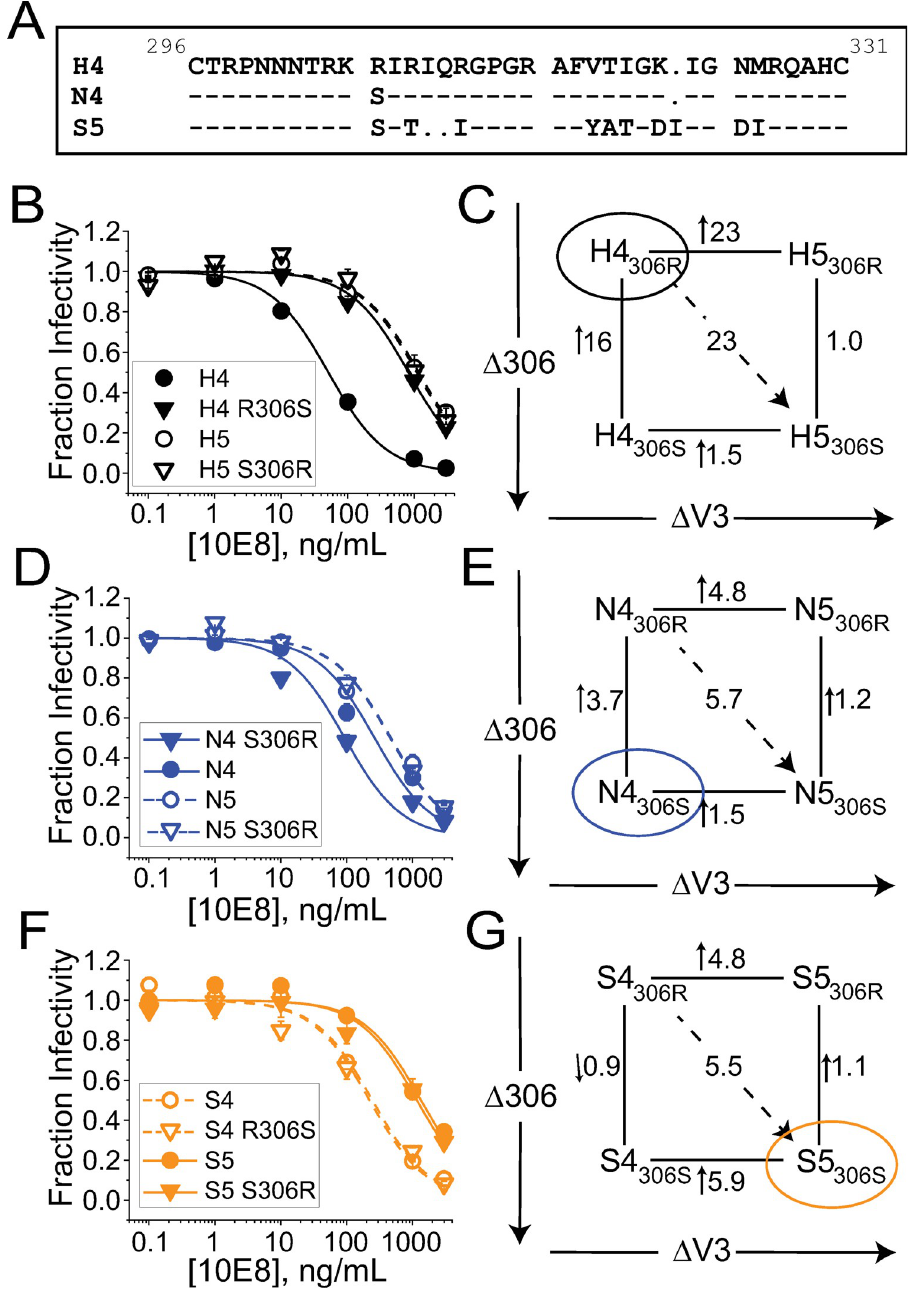
Fig 5. V3-loop residue 306 significantly impacts MPER exposure in Env HXB2 and Env NL4-3 , but not in Env SF162 . ( A ) Sequence alignment of V3 loops from Env HXB2 , Env NL4-3 and Env SF162 . ( B ) Inhibitory titrations of NAb 10E8 against Env HXB2 variants H4 (filled circles), H4 R306S (filled triangles), H5 (open circles) and H5 S306R (open triangles). ( C ) Box representation of the relative effects that residue 306 substitution (vertical) and V3-loop swap (horizontal) exert on the NAb 10E8 sensitivity of Env HXB2 . The numbers adjacent to the lines connecting vertical, horizontal and diagonal points indicate the fold-change in IC50 value for the indicated substitution. ( D, E ) As in B and C , except testing Env NL4-3 . The wild type Env is designated N4 (filled circles), while the V3-loop chimera is designated N5 (open circles). The S306R substitution was incorporated into both N4 and N5 Envs (filled and open triangles, respectively). ( F, G ) As in B and C , except testing Env SF162 . The wild type Env is designated S5 (filled circles), while the V3-loop chimera is designated S4 (open circles). The S306R substitution was incorporated S5 Env (filled triangles), while the R306S substitution was incorporated into S4 Env (open triangles). In each box representation, the wild type Env species is circled.